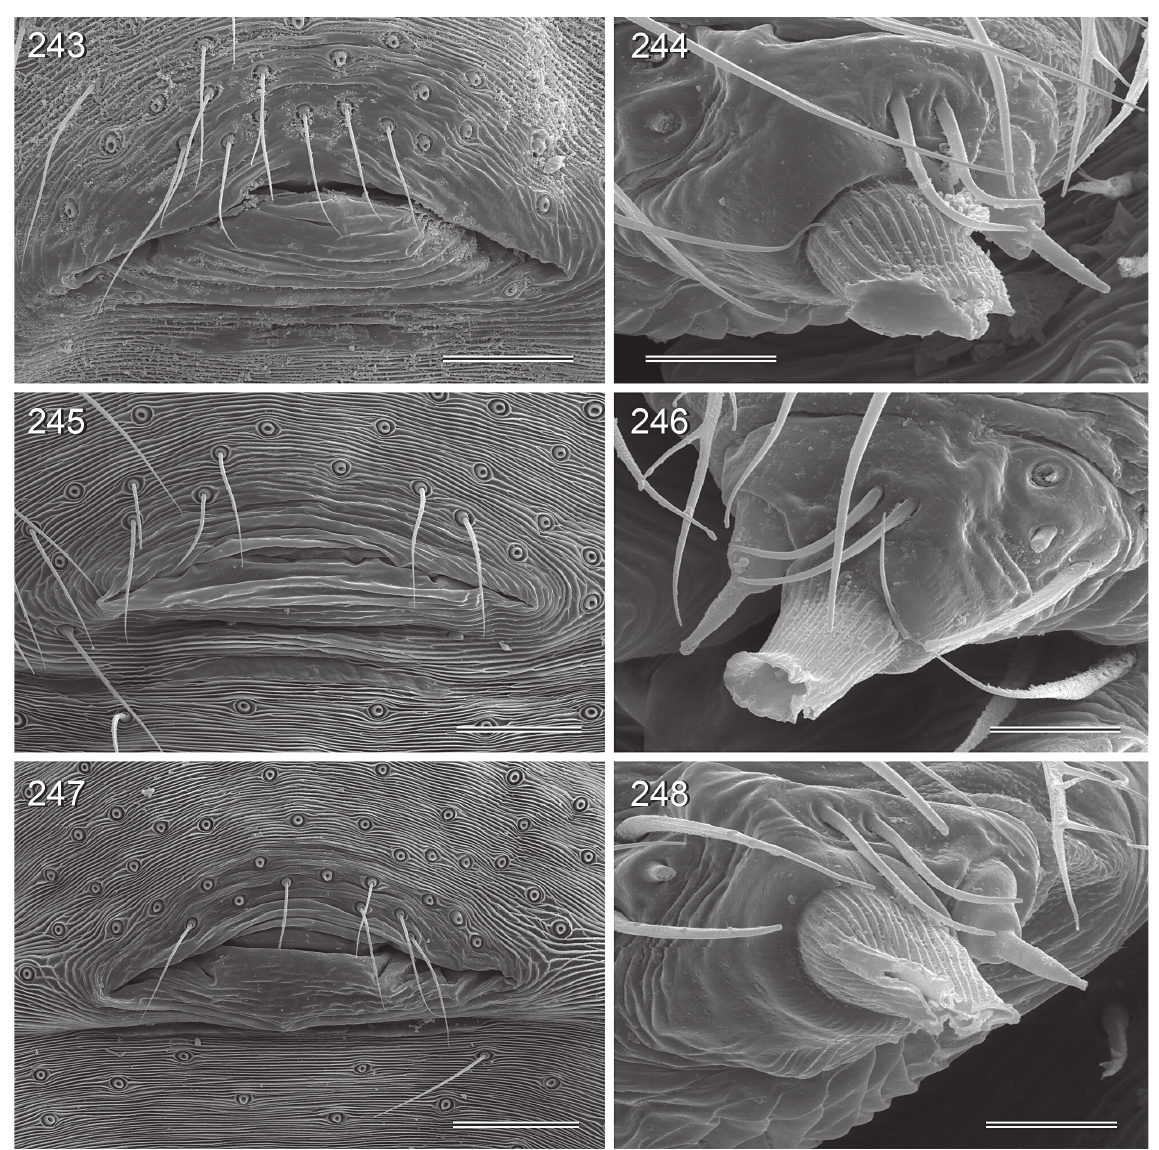
Figs 243–248. Male gonopores and ALS. — 243–244 . Khorata khammouan Huber, 2005. —